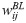
Box-and-whisker plots showing the distribution of information over twenty different subsamples of cells within various layers of the full AN-CN-IC-CX and reduced AN-CX models based on rate (A) and temporal (B) encoding schemes.In B, the A1 neurons are subdivided according to the strength of their connections (wijBL) to the Belt layer. PL and ON layers are not shown. The ON layer conveys 0 bits of information, and PL is equivalent to AN.